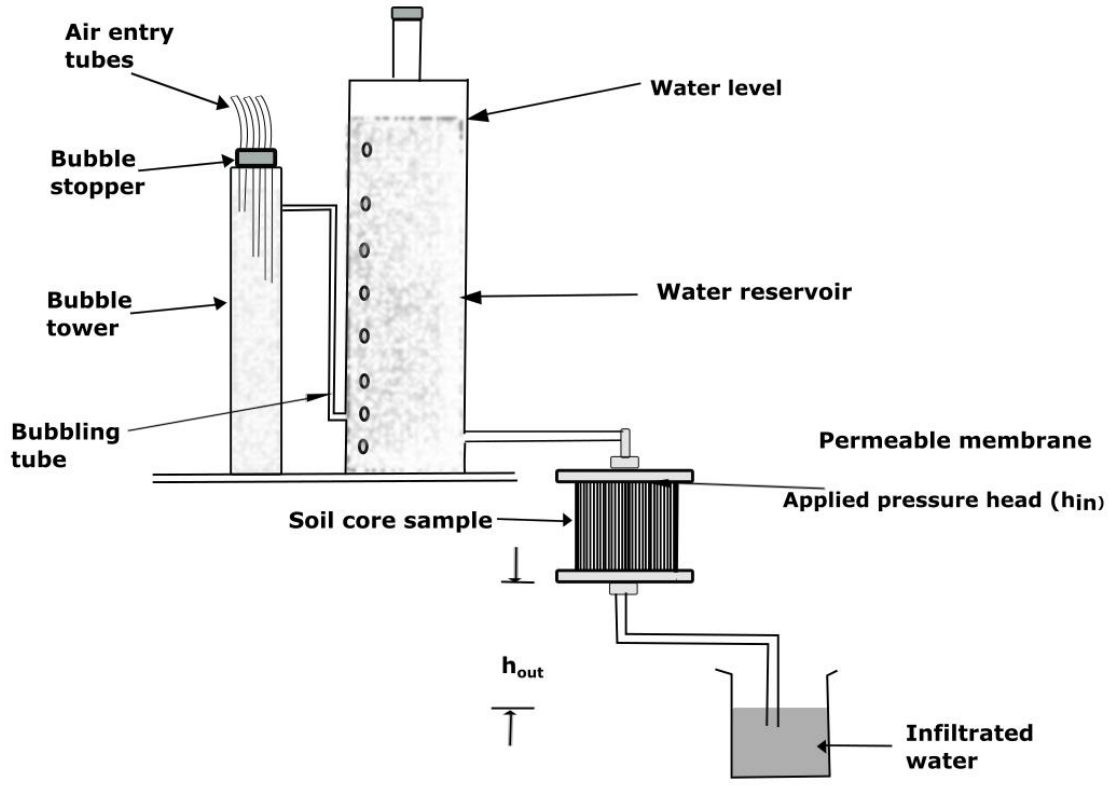
Figure 1. Schematic of the double membrane tension infiltrometer method, redrawn from [36], for measuring hydraulic conductivity near